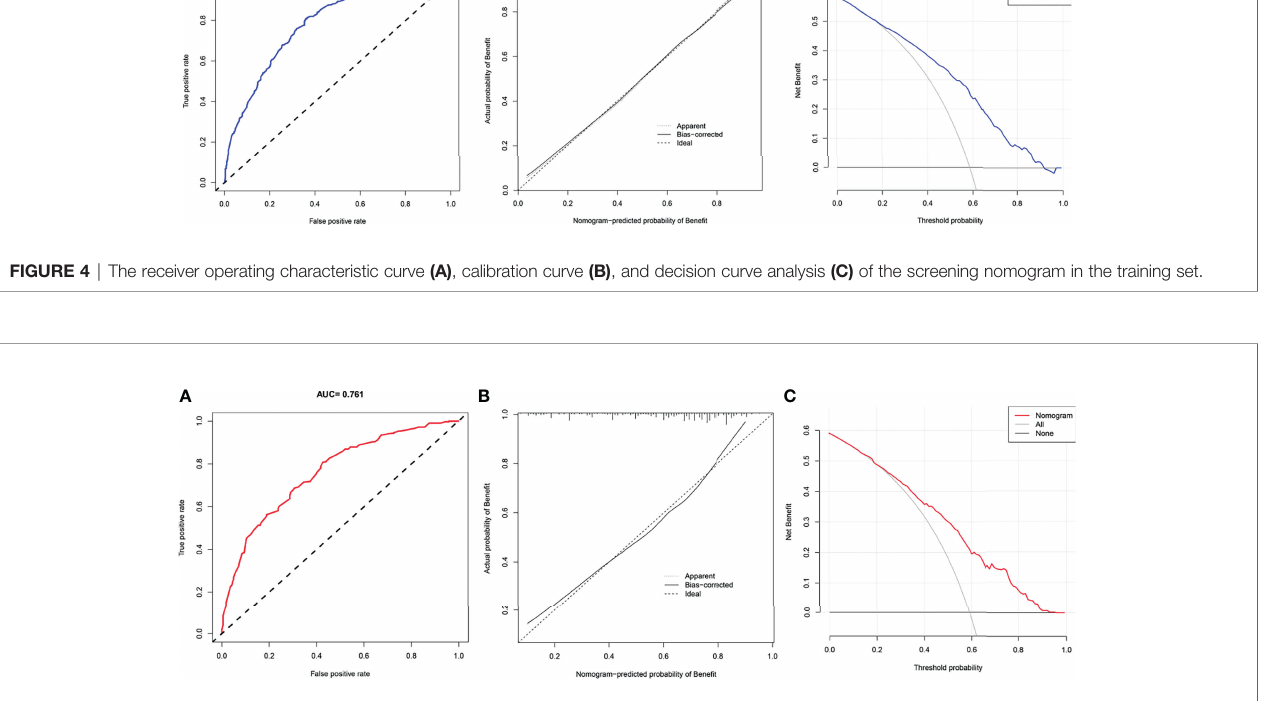
FIGURE 5 | The receiver operating characteristic curve (A) , calibration curve (B) , and decision curve analysis (C) of the screening nomogram in the testing